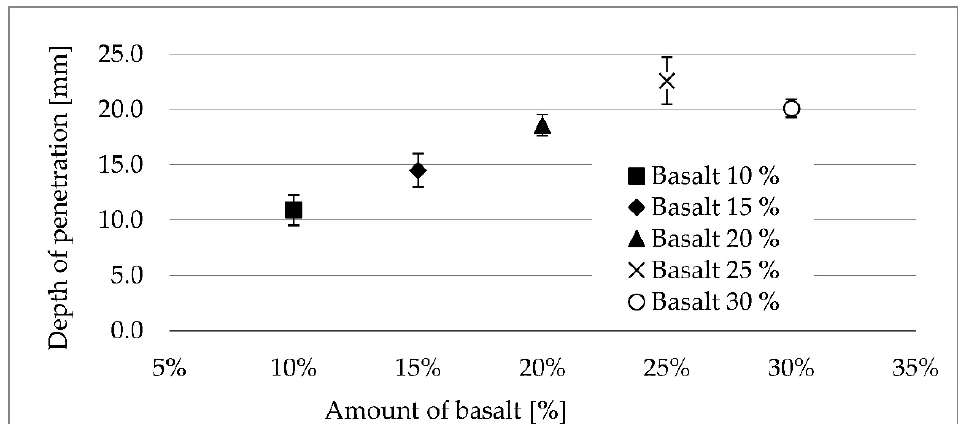
11 of 16 Figure 15. Rear side crater area versus flexural strength.